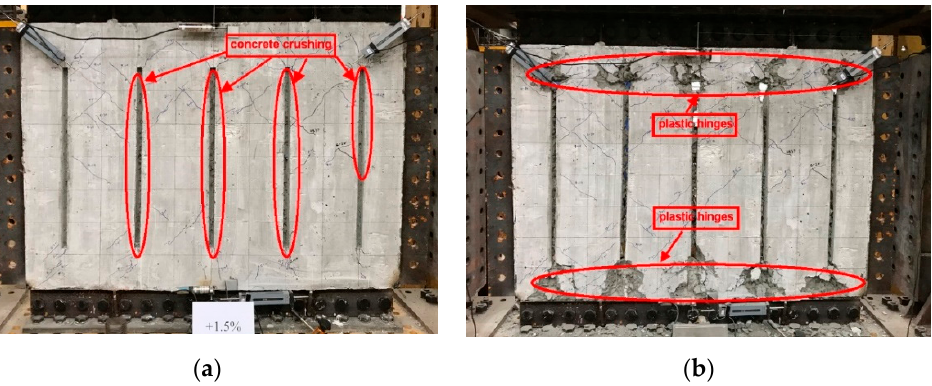
Figure 7. Images of RCIP-2 in different states: ( a ) at a drift ratio of 1.5%; ( b ) front view after the test. RCIP-3 had CHSs in its RC panel, and the hollow part was achieved by placing the foam benzene board. The first crack was monitored at a drift ratio of 0.4%, the crack length was approximately 30 mm, and the inclined angle was approximately 45°, indicating that the shear force mainly induced cracking. Next, long inclined cracks appeared in the middle region of the slit walls. The main difference in the behavior between RCIP-3 and RCIP-1 was that most of the cracks in RCIP-3 were mainly formed in the middle region of the slit walls. At a 0.75% drift ratio, the vertical cracks broadened and extended continuously. When the drift ratio reached 1%, the concrete cover outside the CHSs fell off, and visible penetrating vertical slits were observed. Moreover, parts of the steel rebars yielded. RCIP-3 achieved the maximum lateral load-bearing capacities of 453.9 and − 430.3 kN in the positive and negative loading directions, respectively. Subsequently, the surrounding con- crete of the CHSs was damaged severely (Figure 8a), and plastic hinges were gradually formed at both ends of the slit walls, similar to RCIP-1. Additionally, the lateral strength of RCIP-3 decreased slowly. At a drift ratio of 3.5%, the distributed steel rebars were exposed, cover concrete spall- ing occurred, and the back of the RC panel deformed severely. At a drift ratio of 4%, most of the concrete in the plastic hinge region fell off (Figure 8b). Although the lateral load- bearing capacity of RCIP-3 was high, no visible interface slip was observed during the entire loading process. ( a )